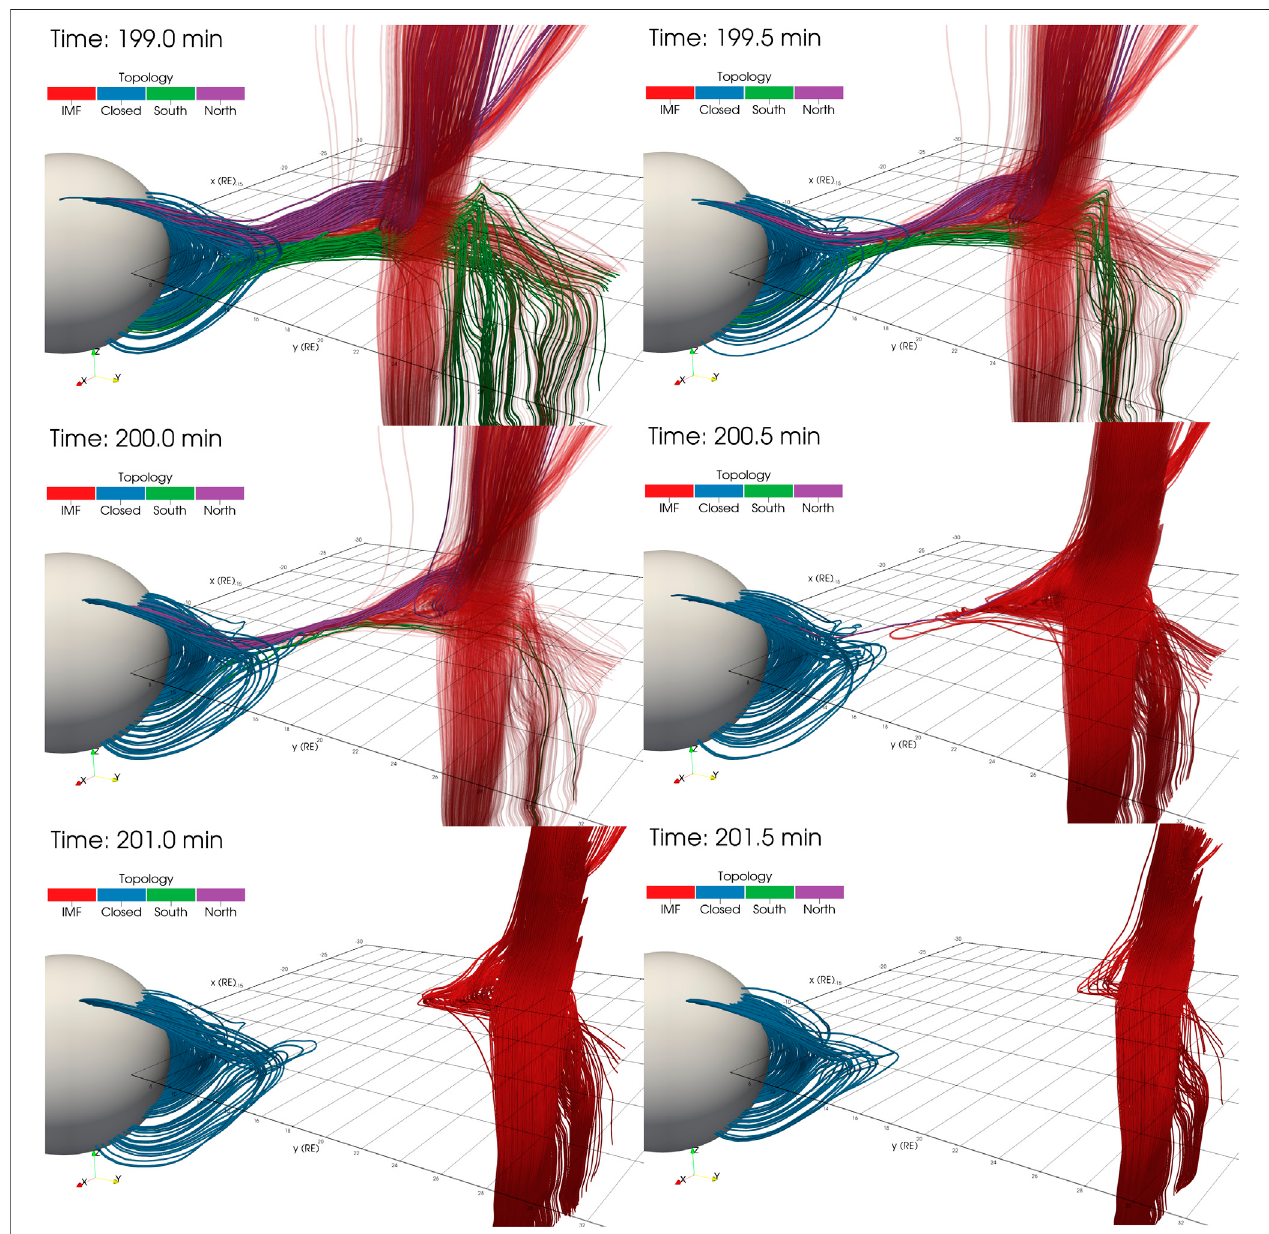
FIGURE 10 | The evolution of fl ux rope three past the nightside reconnection region. The fi eld lines have been drawn so only fl ux rope three is seen, along with the associated closed fi eld line region. Each panel shows a grid in the ecliptic plane z GSE (cid:2) 0. With each row, time increases by 30 s.